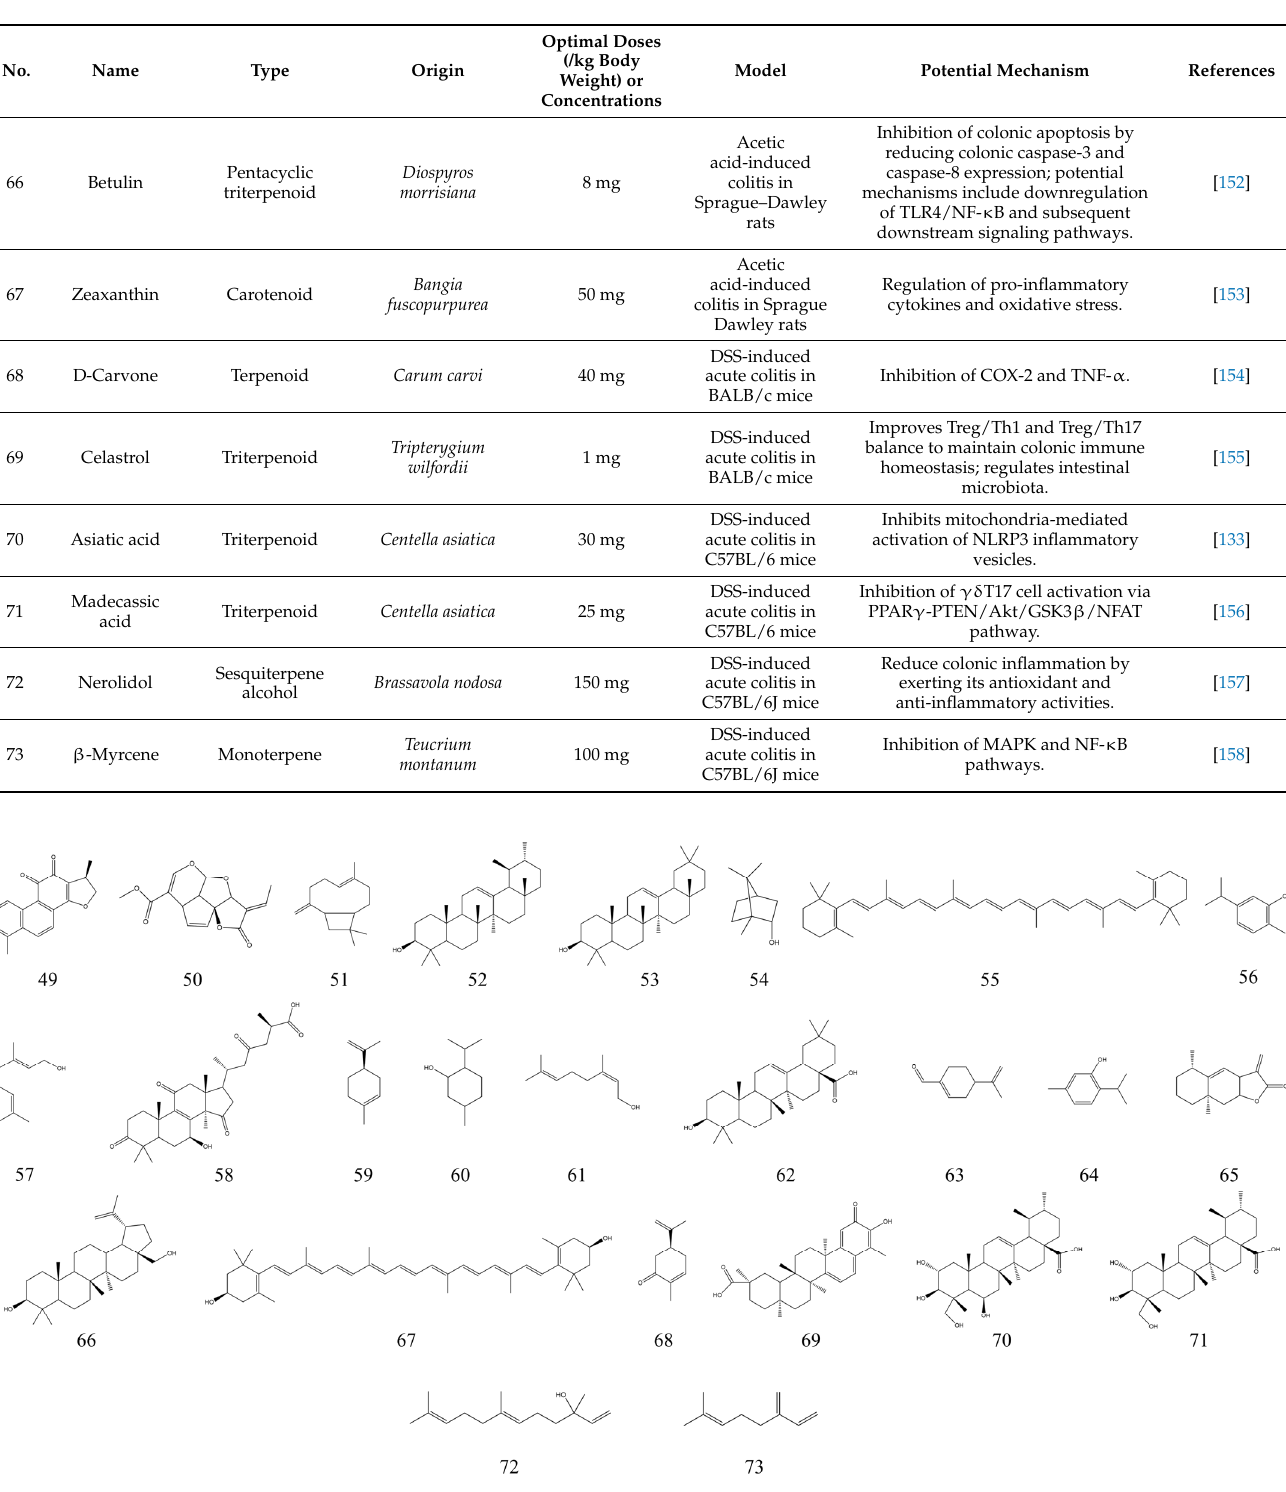
Figure 5. Structural formulae of terpenoids with IBD therapeutic effects.